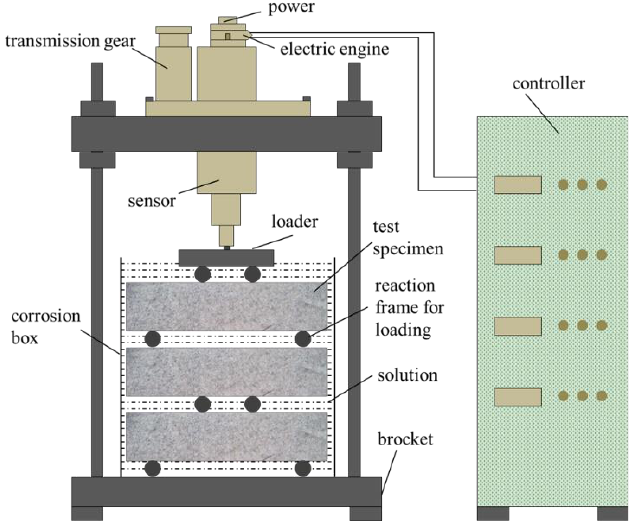
Figure 1. Scheme of the flexural loading device with the erosion chamber.